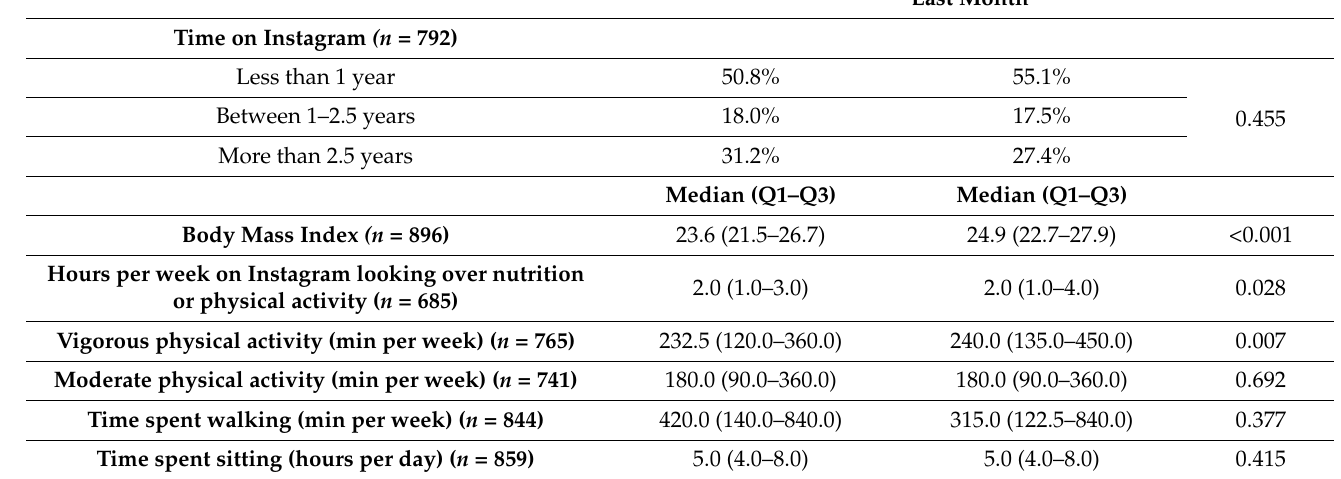
Table 1. Cont. Usage of Any Meal Tracker Platform to Record Food Intake over